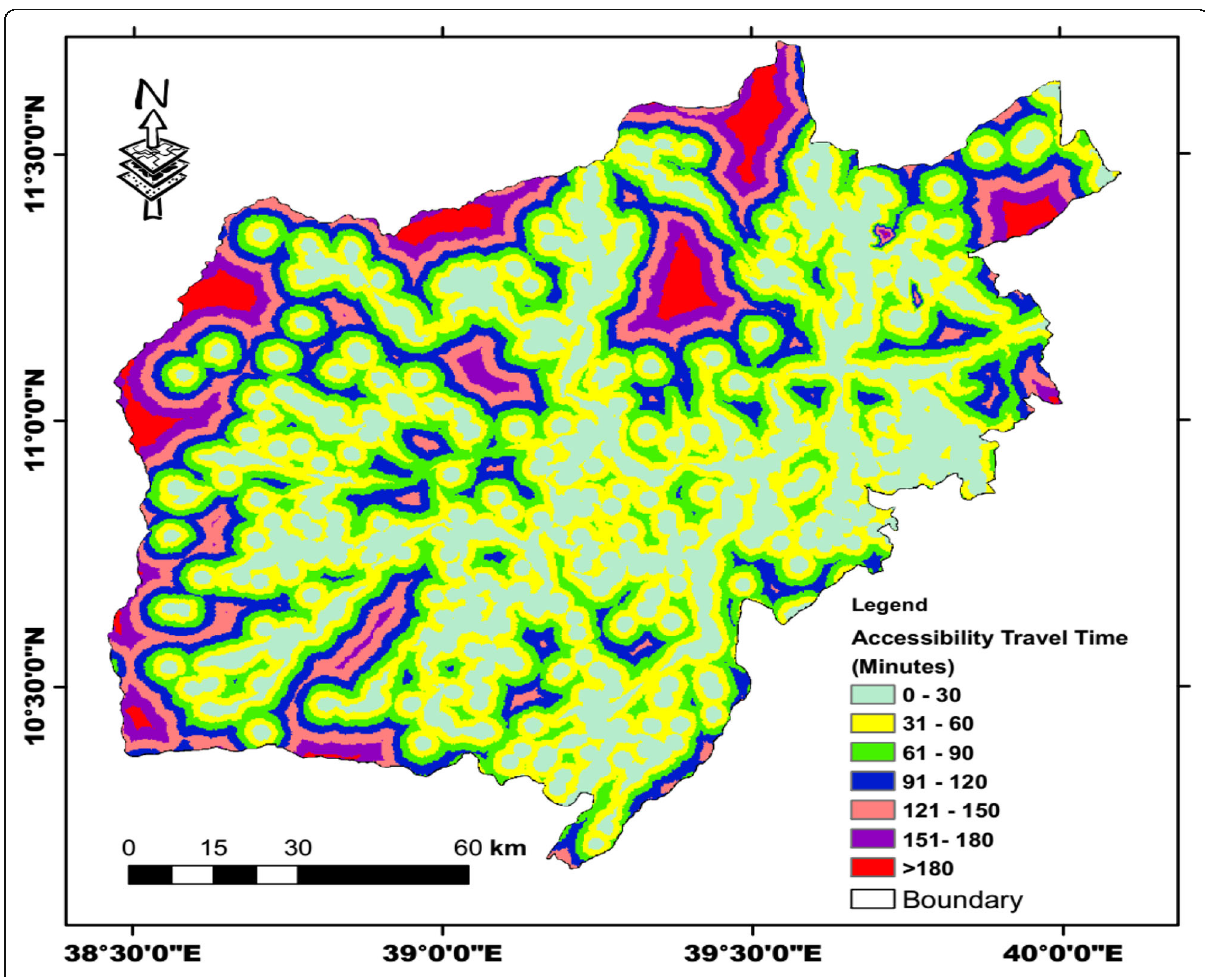
Fig. 8 The aggregated accessibility travel time to service centers of market place, school, and health institutions of South Wollo administrative